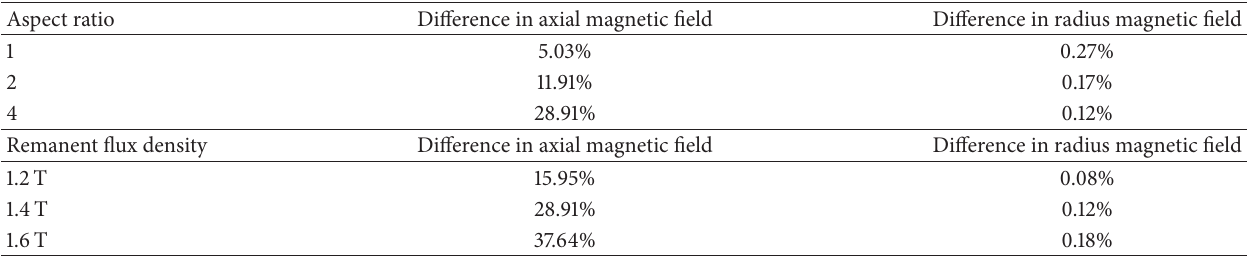
Table 1: Percentage difference of magnetic field along axial and radius position of GMM with different design parameters.